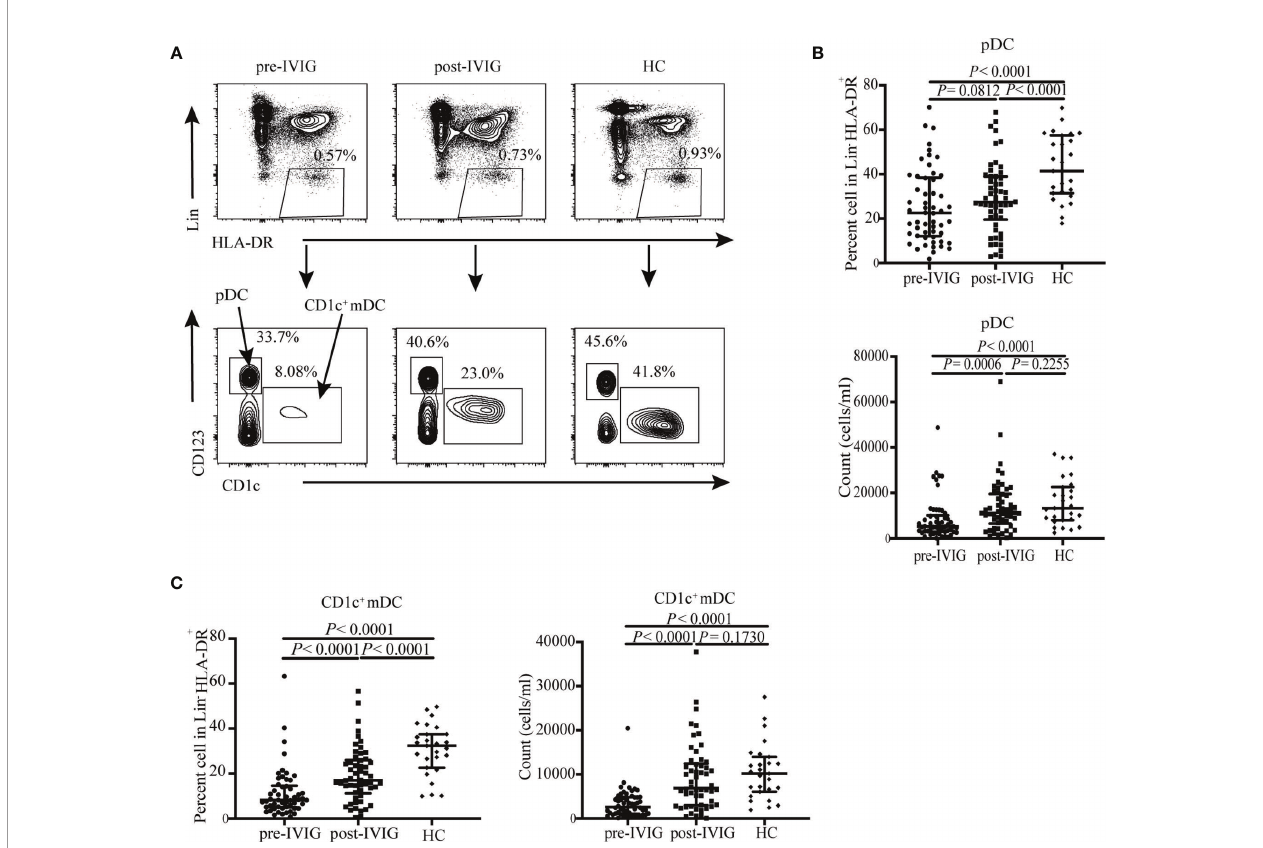
FIGURE 1 | DC subsets distribution in HCs (n = 27) and KD patients pre- and post-IVIG treatment (n = 54). (A) Identi fi cation of circulating DC subsets in blood using fl ow cytometry, Pan-DCs were gated as Lin - HLA-DR + , pDCs and CD1c + mDCs were de fi ned as Lin − HLA-DR + CD123 + and Lin − HLA-DR + CD1c + cells, respectively. Representative pro fi les of the circulating DCs subsets are shown. (B) Plots show percentage and number of circulating pDCs in patients with KD and controls. (C) Plots show percentage and number of circulating CD1c + mDCs in patients with KD and HCs. Horizontal bars represent median values, and error bars represent the interquartile